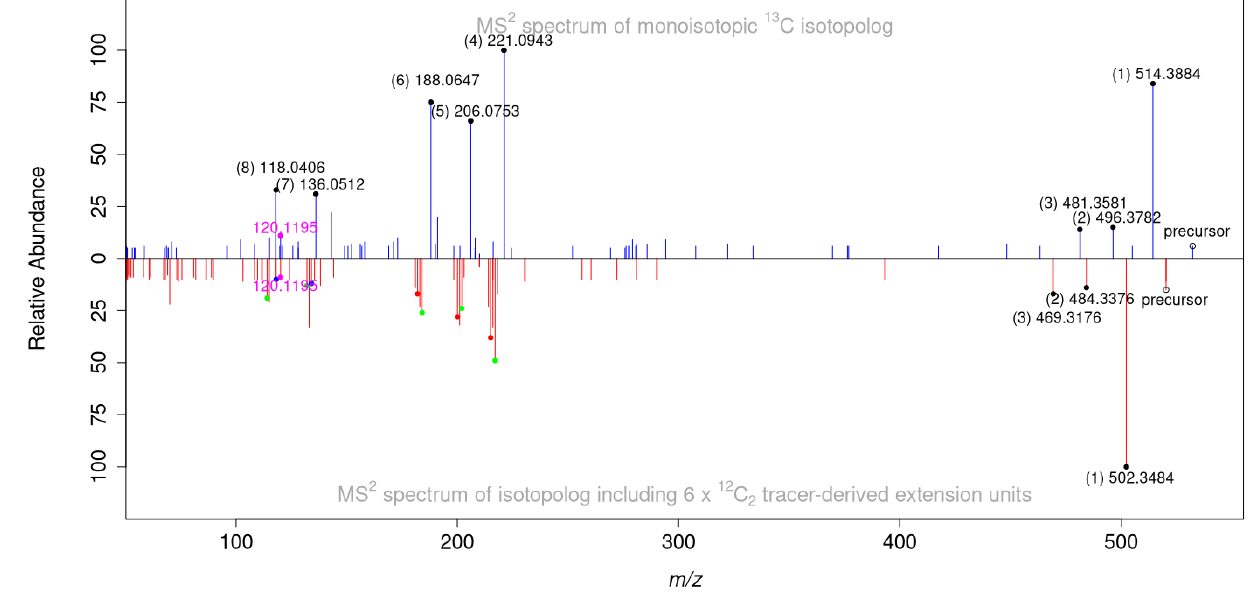
Figure 6. Comparison of MS/MS spectra of the fully 13 C labeled form of C 29 H 42 O 7 [M + H] + ion at m/z 532.3976 (shown in blue) with the corresponding isotopolog carrying six tracer-derived extension units in the metabolite (shown in red). Peaks with corresponding m/z shifts are marked with black dots in the monoisotopic spectrum and as colored dots in the tracer containing isotopolog, indicating the number of tracer-derived extention units (from 6 to 3 extension units, marked as black (6), red (5), green (4) and blue (3), respectively). A single fragment of identical mass not showing a mass shift is marked in magenta. Numbers in brackets indicate the respective peak assignment.